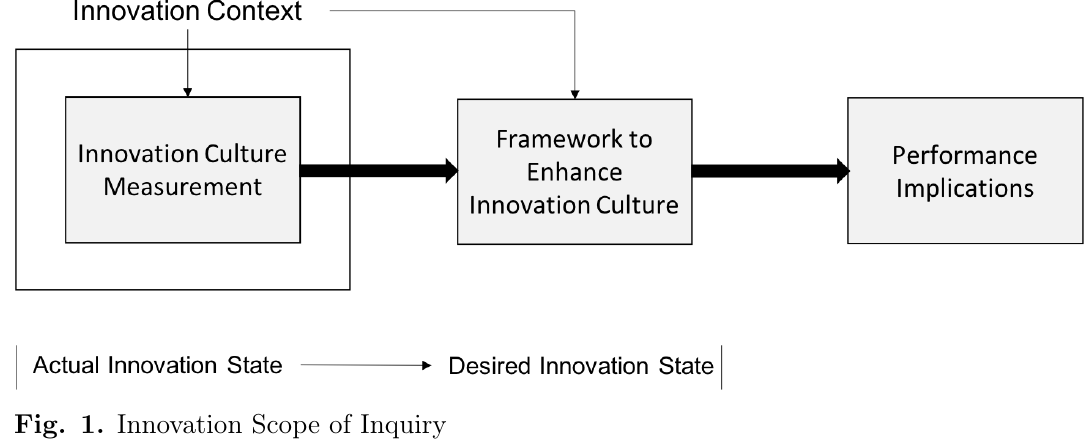
Fig. 1. Innovation Scope of